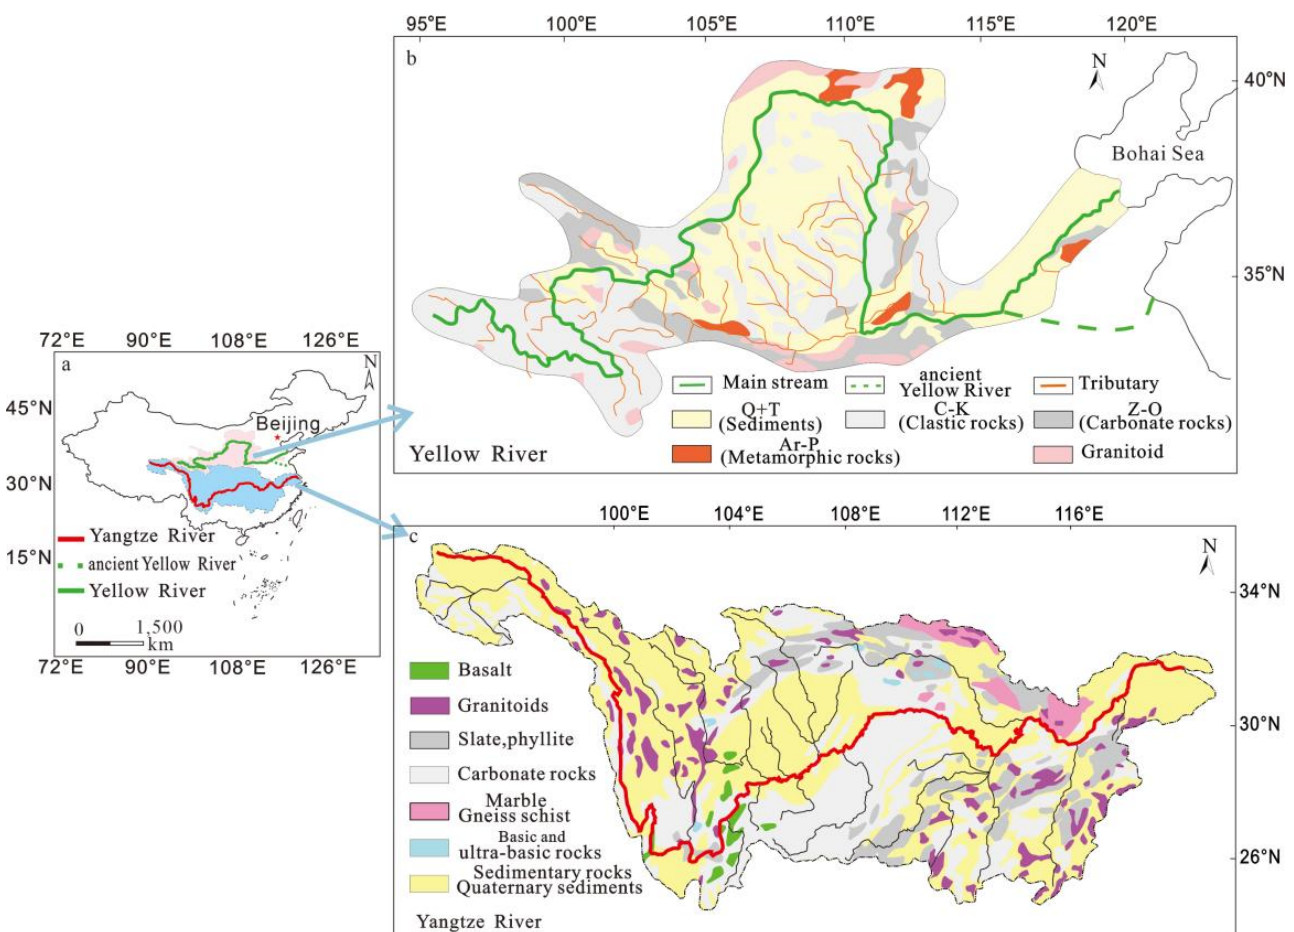
Figure 7. Geological map of the drainage basins in this study (modified based on Hongfei [60] and Wang [18]).